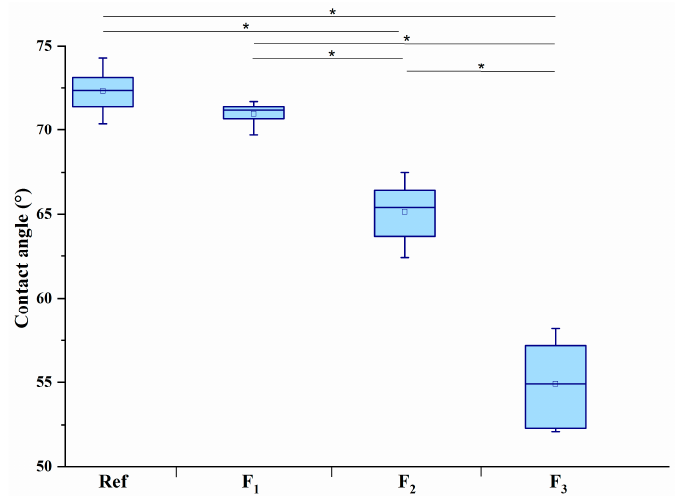
Figure 2. The wettability of the surface modified with different laser parameters; statistical significance between the study groups for water and PBS, obtained in one-way ANOVA and post-hoc Tukey’s tests; * p < 0.001.